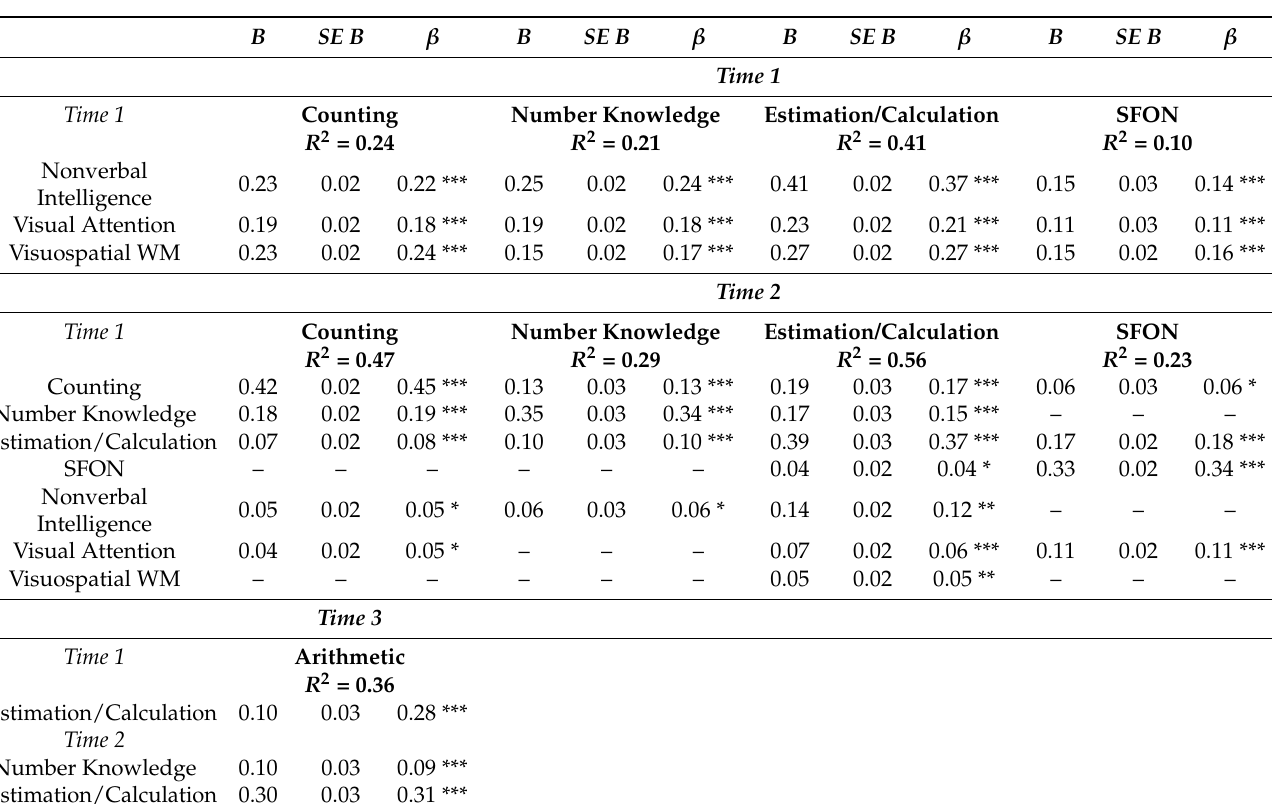
Table 4. Path analysis results.